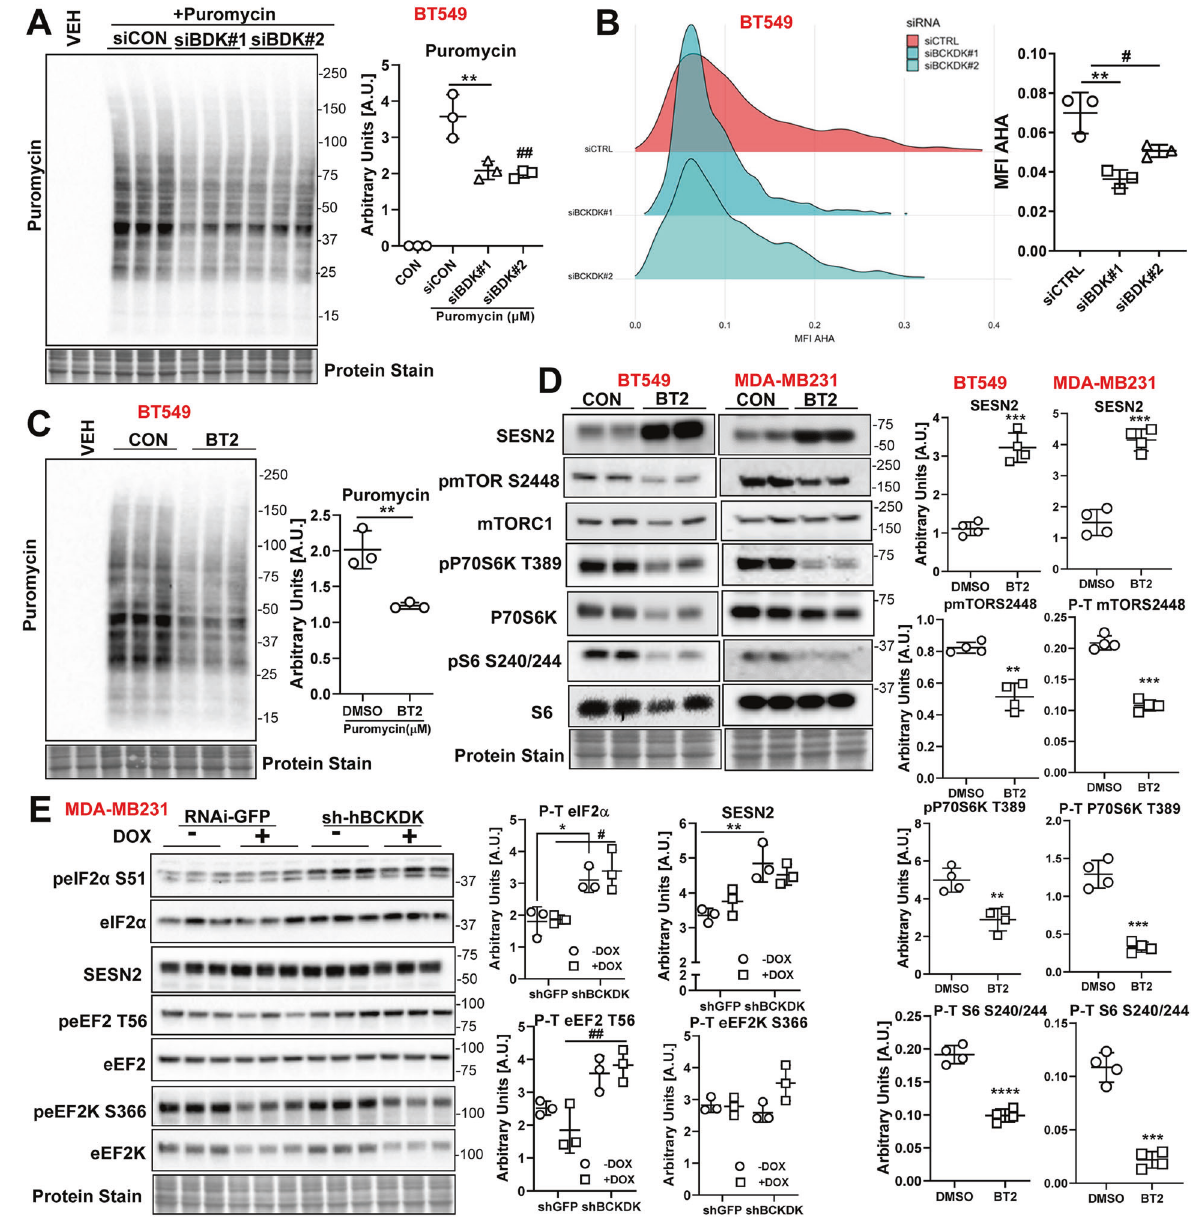
Fig. 6 BCKDK inhibition decreases protein synthesis and mTOR signaling in TNBCs. A BT549 was transfected with siCON, siBDK#1, or siBDK#2 for 72 h followed by incubation with 1 μ M puromycin for 30 min. Immunoblot and densitometric analysis of puromycin incorporation. B Fluorogram and quanti fi cation of AHA incorporation in BT549 cells transfected with siCON, siBDK#1, or siBDK#2. C Immunoblot and densitometric analysis of puromycin incorporation in BT549 cells treated with 500 µM BT2 for 20 h followed by incubation with 1 μ M puromycin for 30 min. The graph represents mean ± S.D., n = 3, * p < 0.05 was performed using Student ’ s t test. D Immunoblot and densitometric analysis of SESN2, total and phosphorylated mTOR S2448, total and phosphorylated P70S6K T389, and total to phosphorylated S6 S240/244 in BT549 and MDA-MB231 cells treated with 500 µM BT2 for 20 h. Data presented as mean ± S.D. Statistical analysis was performed using Student ’ s t test; * p < 0.05, ** p < 0.01, **** p < 0.0001 as indicated. Immunoblot and densitometric analysis of total and phosphorylated eIF2 α S51, Sesn2, total and phosphorylated eEF2 T56, total and phosphorylated eEF2K S266, total and phosphorylated AKT S473, and AKT T308 in MDA-MB231 cells transduced with shGFP or shBCKDK for 48 h followed by 2 µM DOX or DMSO treatment for 18 h. Quanti fi cations are from three independent experiments. A – B , *siCON vs siBDK#1, #siCON vs siBDK#2; E , *shGFP vs sh-hBCKDK, #shGFP + DOX vs sh-hBCKDK + DOX. Data presented as mean ± S.D. Statistical analysis was performed using a two-way ANOVA followed by a Tukey ’ s multiple comparison test; * p < 0.05, ** p < 0.01, **** p < 0.0001 as Silencing BCKDK reduces protein synthesis in TNBCs Previous studies have demonstrated that induction of ER stress silencing (Fig. 6B). A similar reduction in puromycin incorporation and mitochondrial dysfunction [20] induces apoptosis [21] and was observed in BT549 cells treated with BT2 (Fig. 6C). In both inhibits protein translation and synthesis. As measured by BT549 and MDA-MB231 cells, BT2 treatment resulted in a robust puromycin incorporation, protein synthesis was reduced in BCKDK